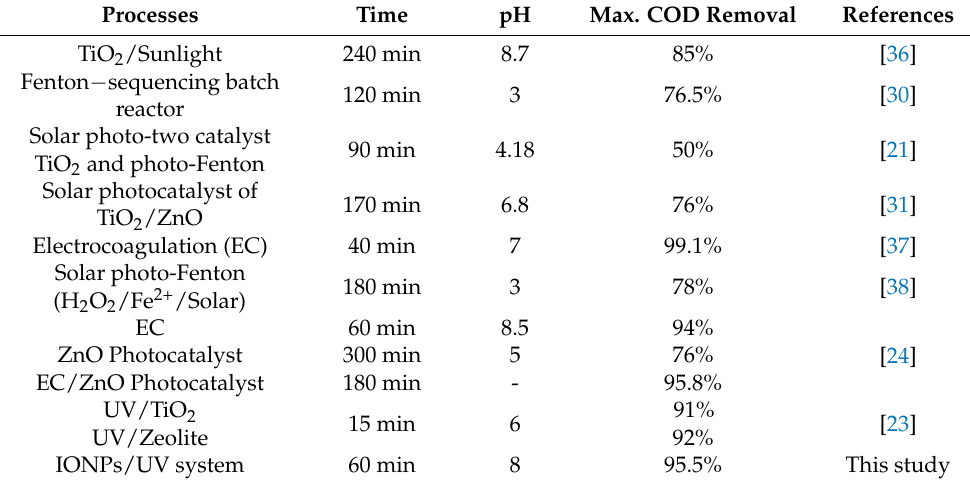
Table 3. Comparison of COD removal from petroleum wastewater by available